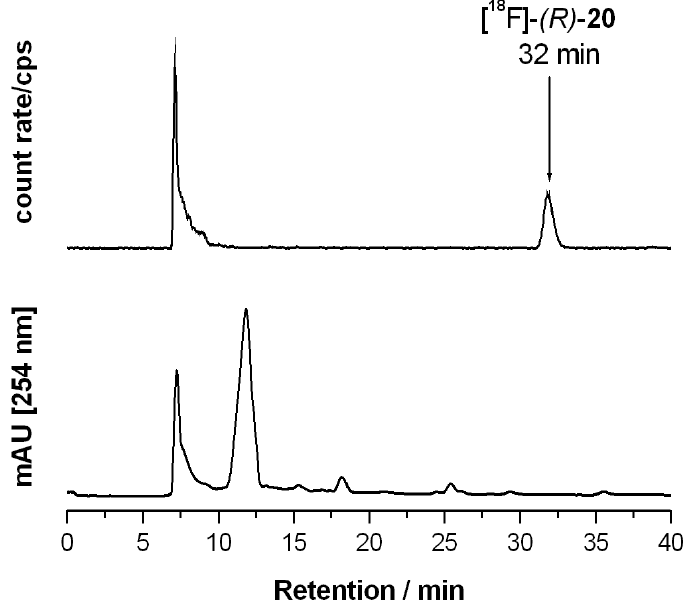
Figure 3. Semi-preparative HPLC separation of the crude labelling mixture of [ 18 F]- ( R )- 20 . HPLC chromatogram with radioactivity detection (above) and UV detection